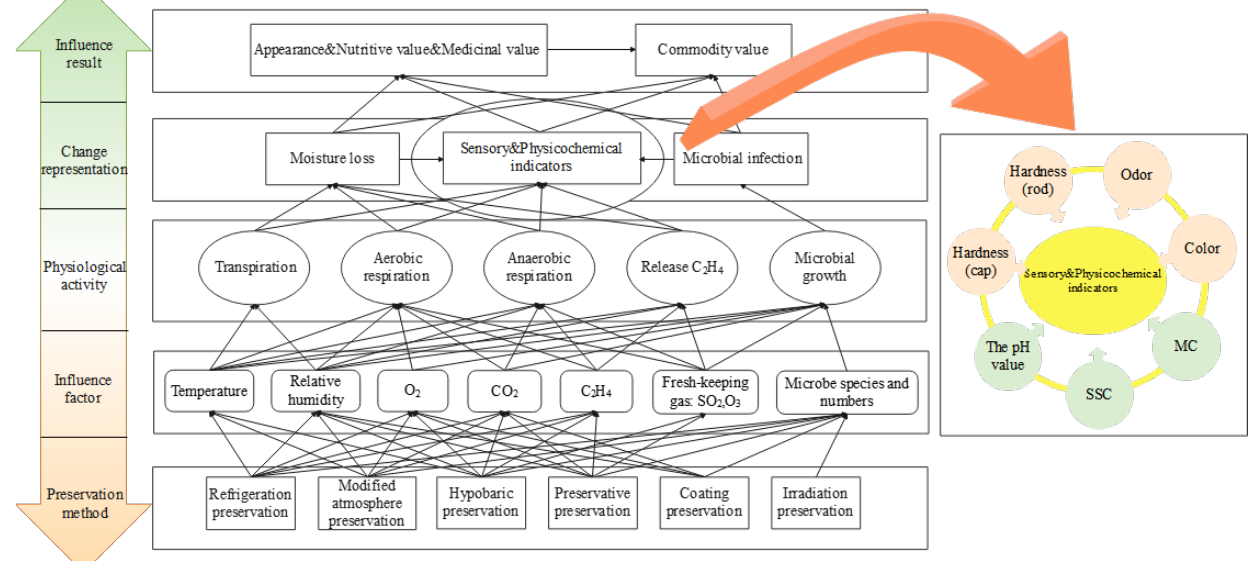
Figure 2. Matsutake quality change mechanism during the preservation